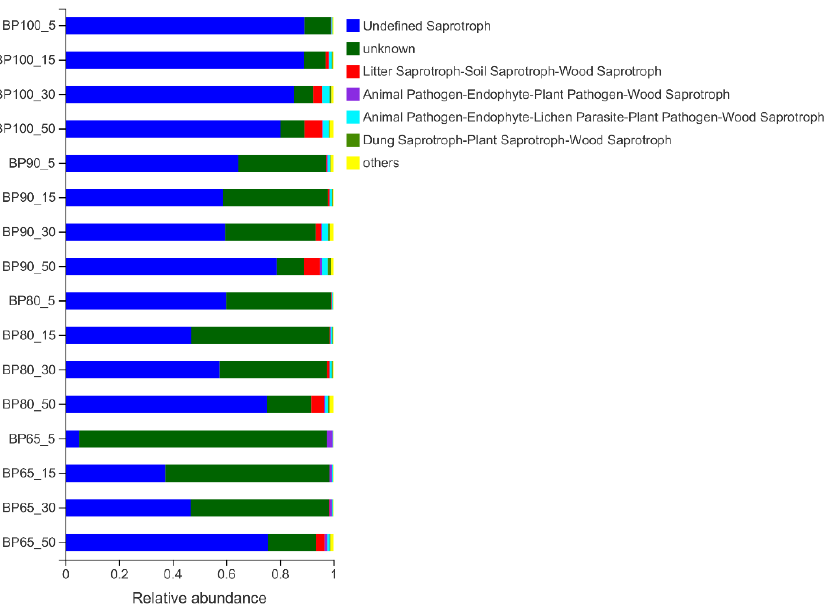
Figure 8. Variations in fungal functional groups compositions inferred by FUNGuild.